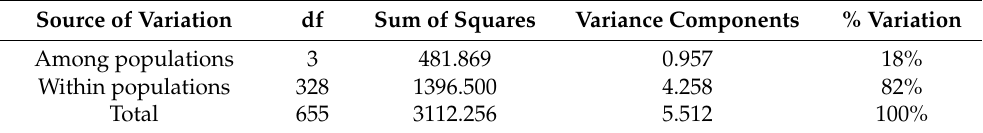
Table 1. Analysis of molecular variance (AMOVA) based on 14 STR markers. The AMOVA result revealed that individual variation was greater (82%) than the variation in the inter-population (18%). Source of Variation df Sum of Squares Variance Components % Variation Among populations 3